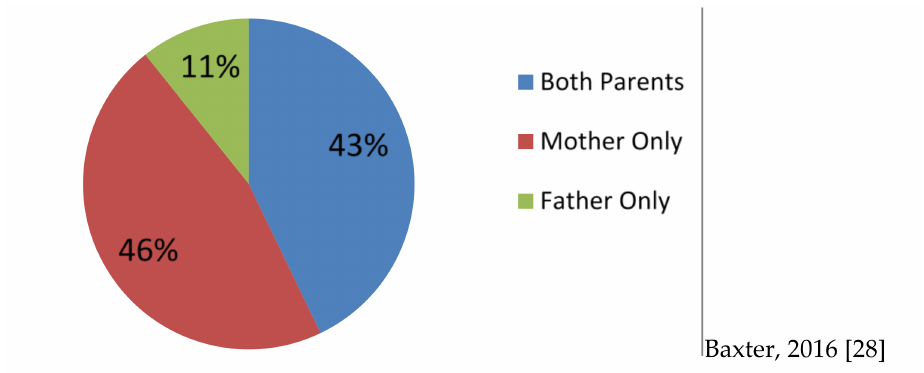
Figure 1. Parents’ share of the time they spend with their children in two-parent